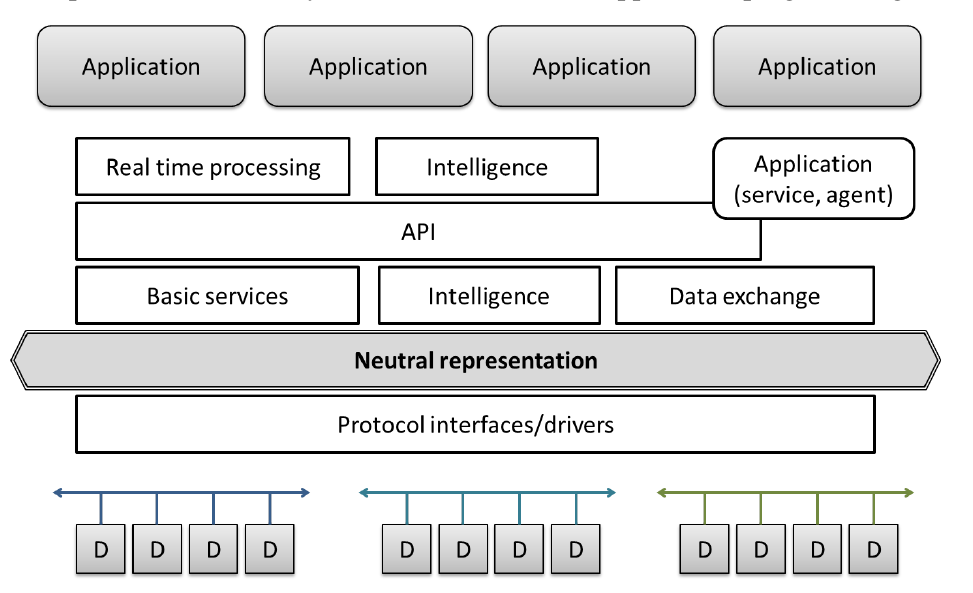
Figure 4. Open and horizontal system architecture. API: application programming